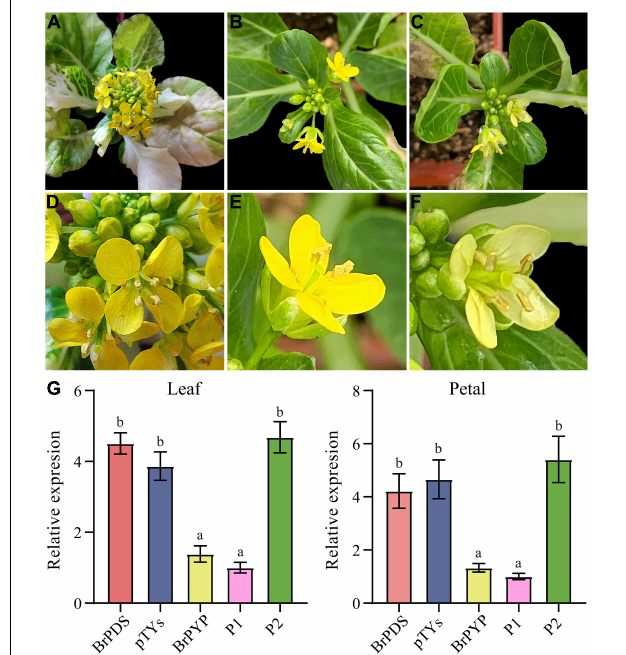
FIGURE 4 | Transient silencing of BrPYP resulted in pale-yellow petals. (A) The evirus-induced gene silencing (VIGS)-mediated BrPDS gene silencing phenotype of flowering Chinese cabbage leaves. (B) Flowering Chinese cabbage plants were agro-drenched with empty pTYs vectors. (C) The VIGS-mediated BrPYP gene silencing phenotype of flowering Chinese cabbage petals. (D–F) Enlarged images of (A–C) , respectively. (G) qRT-PCR analysis of VIGS-mediated BrPYP in flowering Chinese cabbage leaves and petals. The letters above the bars indicate significant differences at P < 0.05 (Student’s